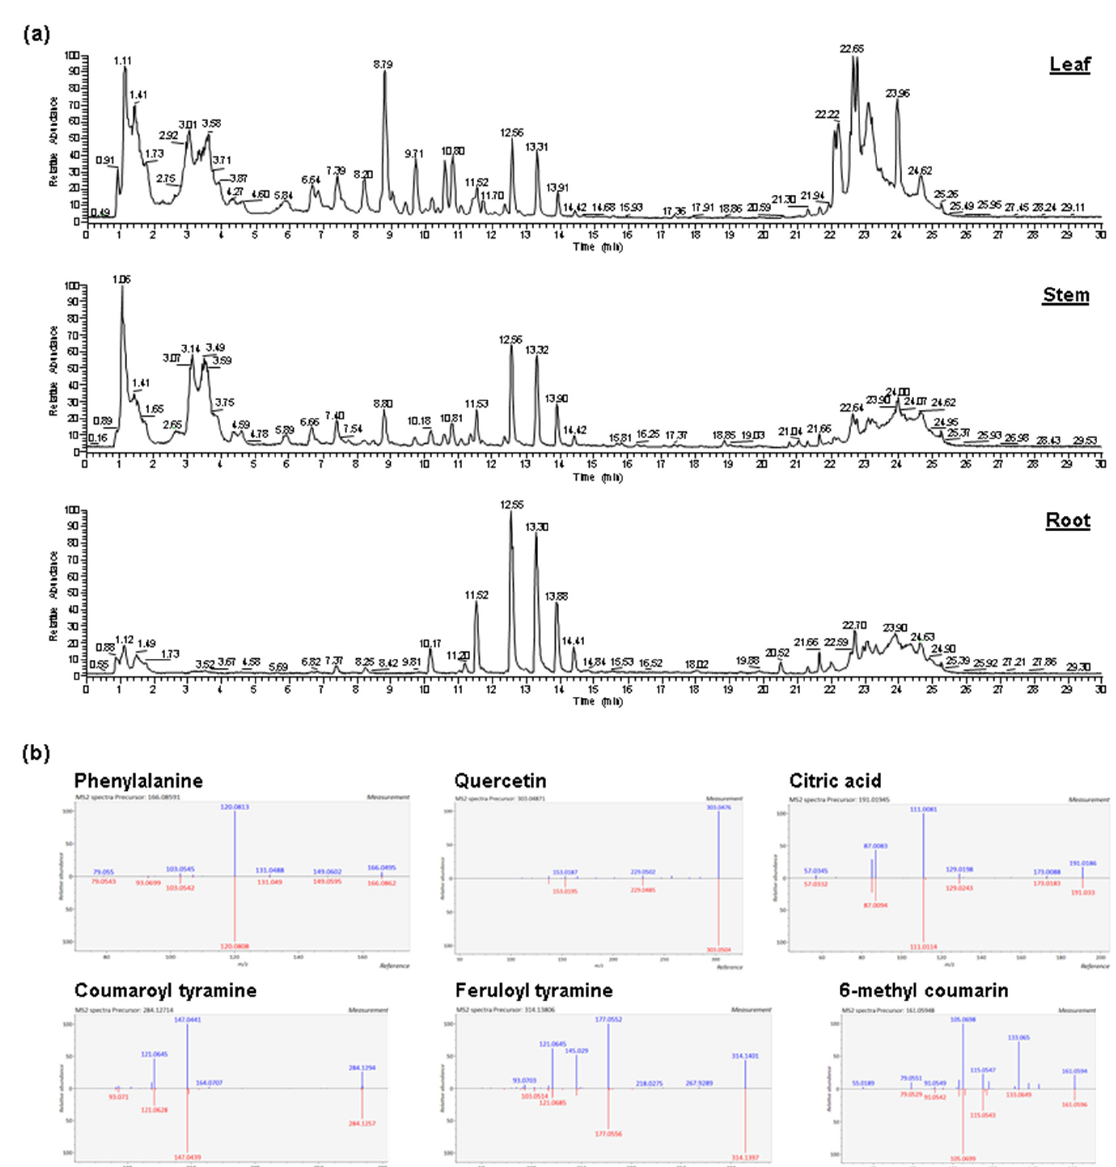
Figure 1. ( a ) Total ion chromatograms (TICs) of metabolites extracted from the leaf, stem, and root tissues of Amborella trichopoda . ( b ) Representative MS/MS spectral comparisons of the A. trichopoda metabolites (measurement) with the corresponding phytochemical standards in the publicly available mass spectral libraries (reference).